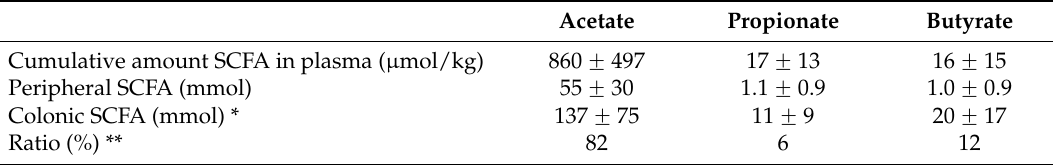
Table 4. Cumulative amount (AUC) of exogenous short chain fatty acid (SCFA) production, SCFA in